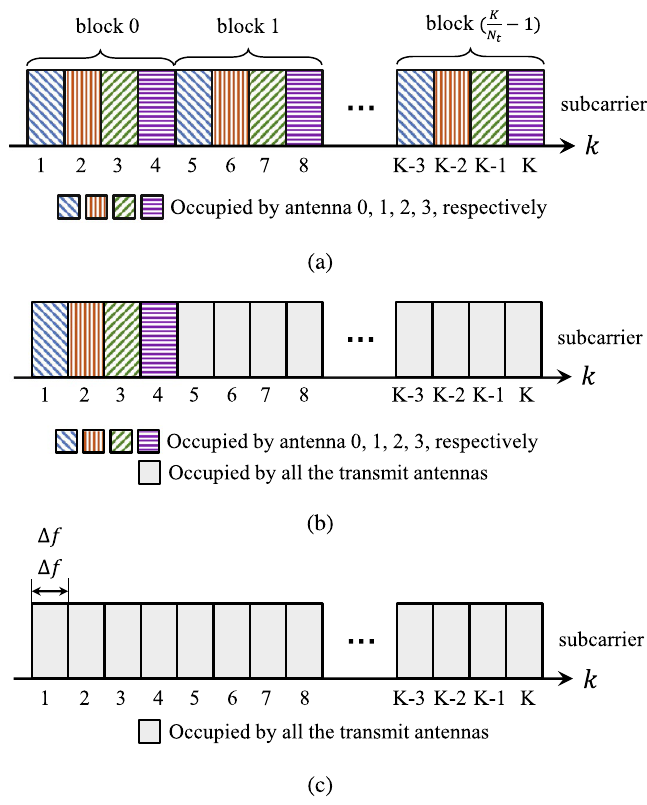
Fig. 2 Illustration of different transmitting principles. a Orthogonal transmitting; b Partially orthogonal transmitting; c Fully nonorthogonal